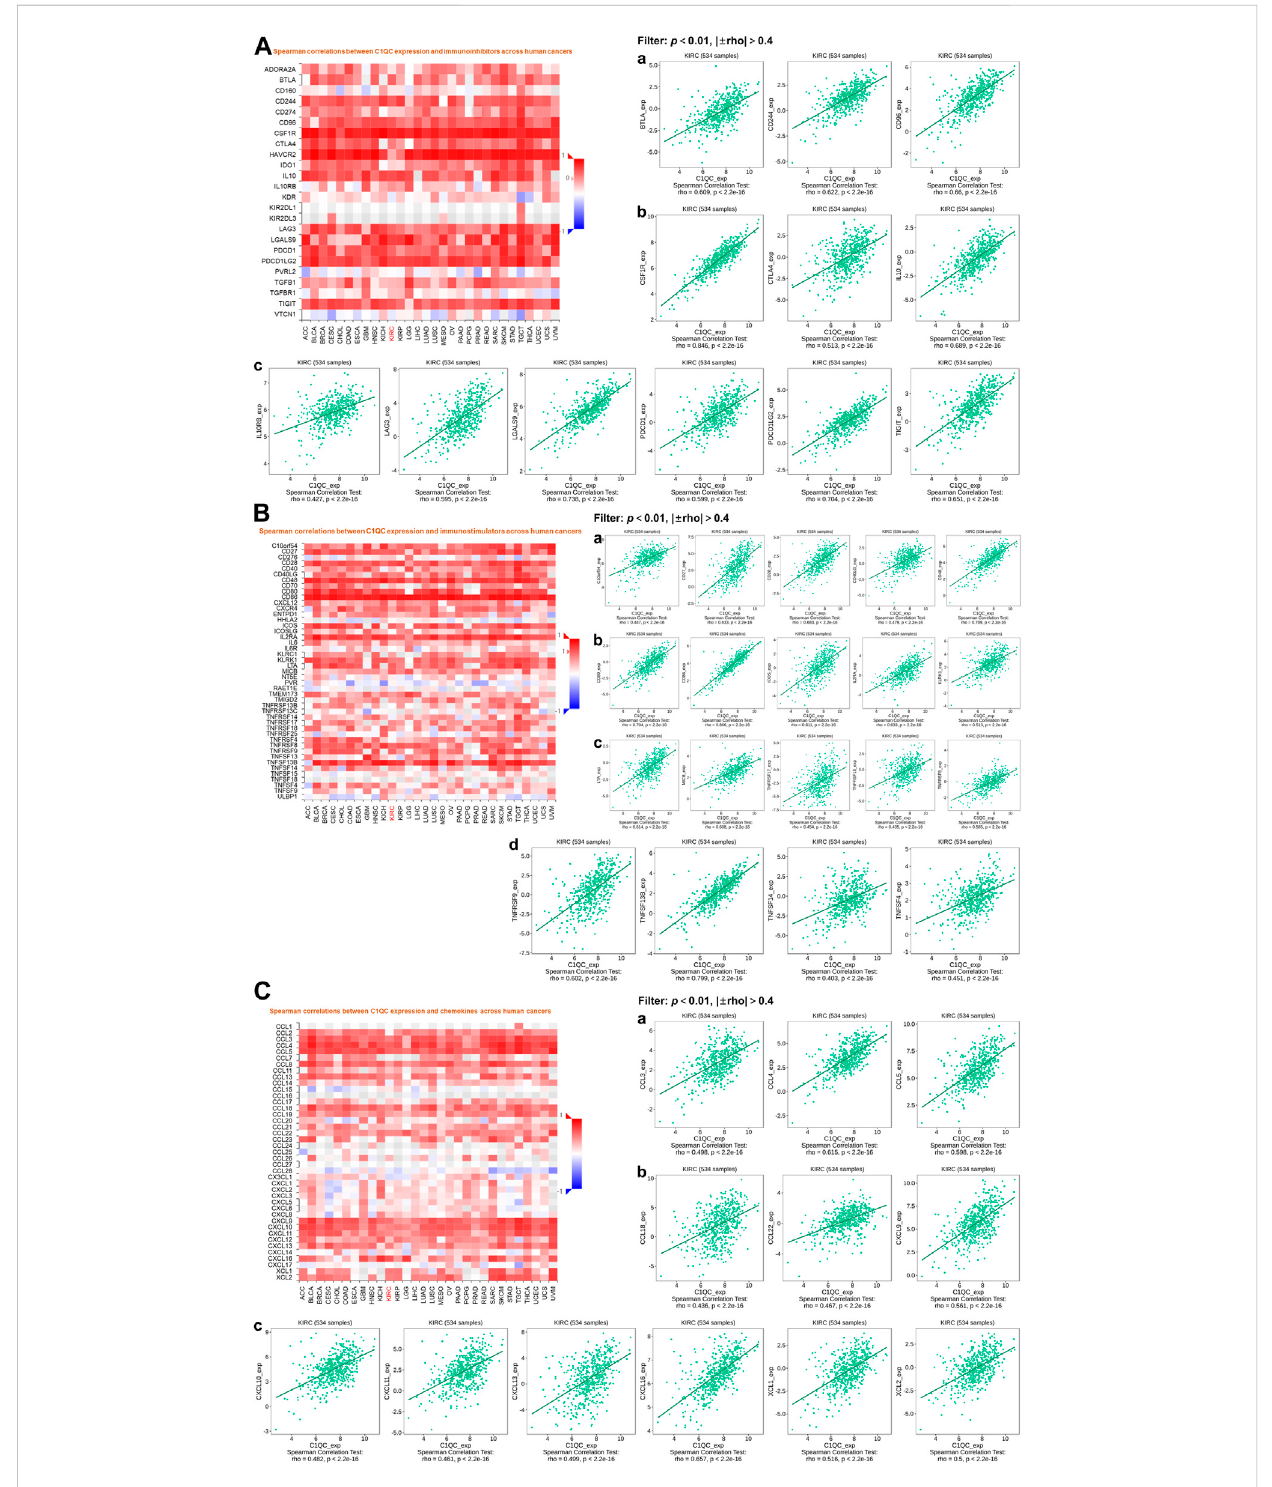
FIGURE 7 Associations of C1QC expression with 3 cancer-related immune factor types in KIRC. (A) Immunoinhibitors. (B) Immunostimulators. (C) Chemokines. ( A – C : Heat maps show associations of C1QC and immune factors in different cancers; a – d : Line graphs show associations of C1QC with speci fi c immunomodulators in